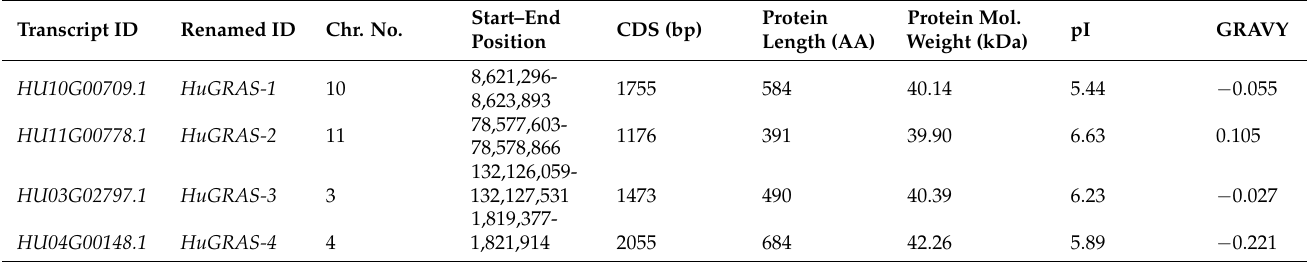
Table 1. Physical and chemical properties of GRAS genes in pitaya ( S. undatus